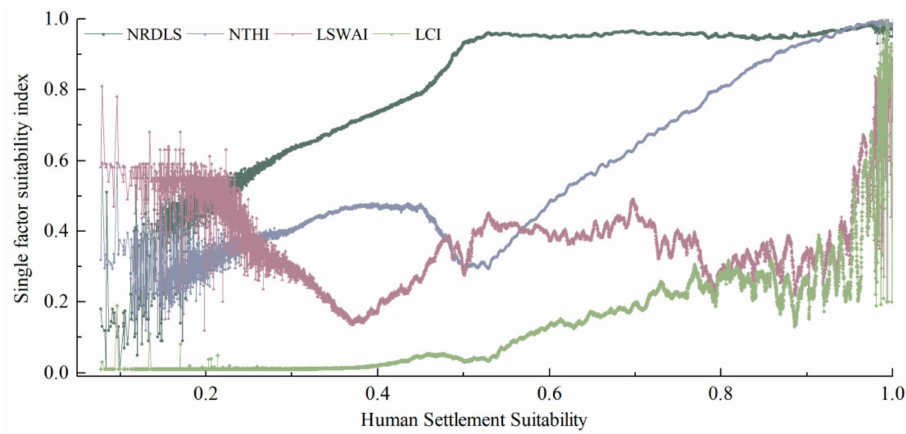
Figure 6. Correlations between the HSS and the single-factor index